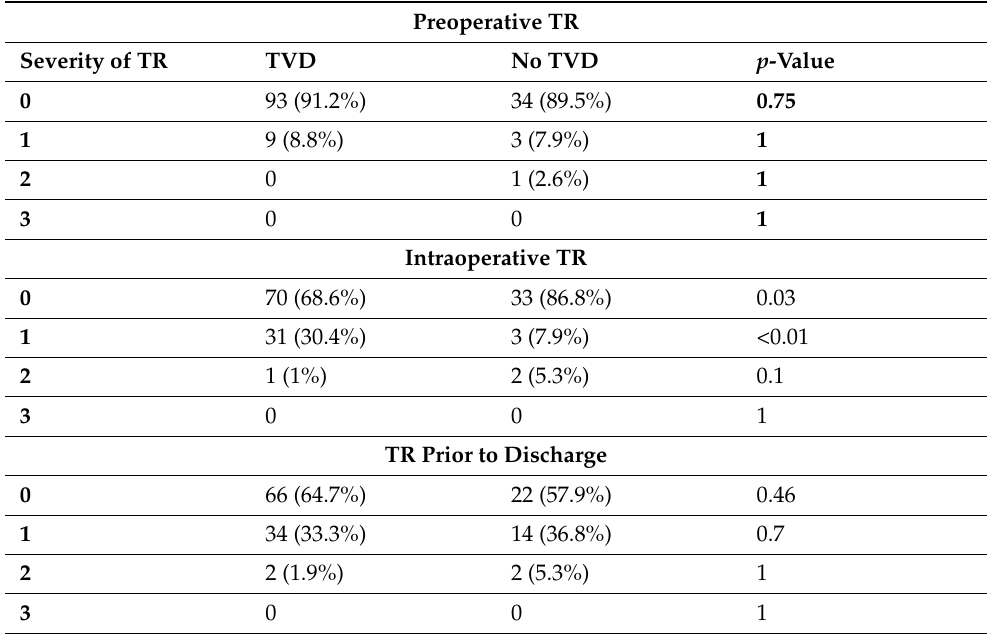
Table 2. Pre-, intra-, and postoperative tricuspid regurgitation in both